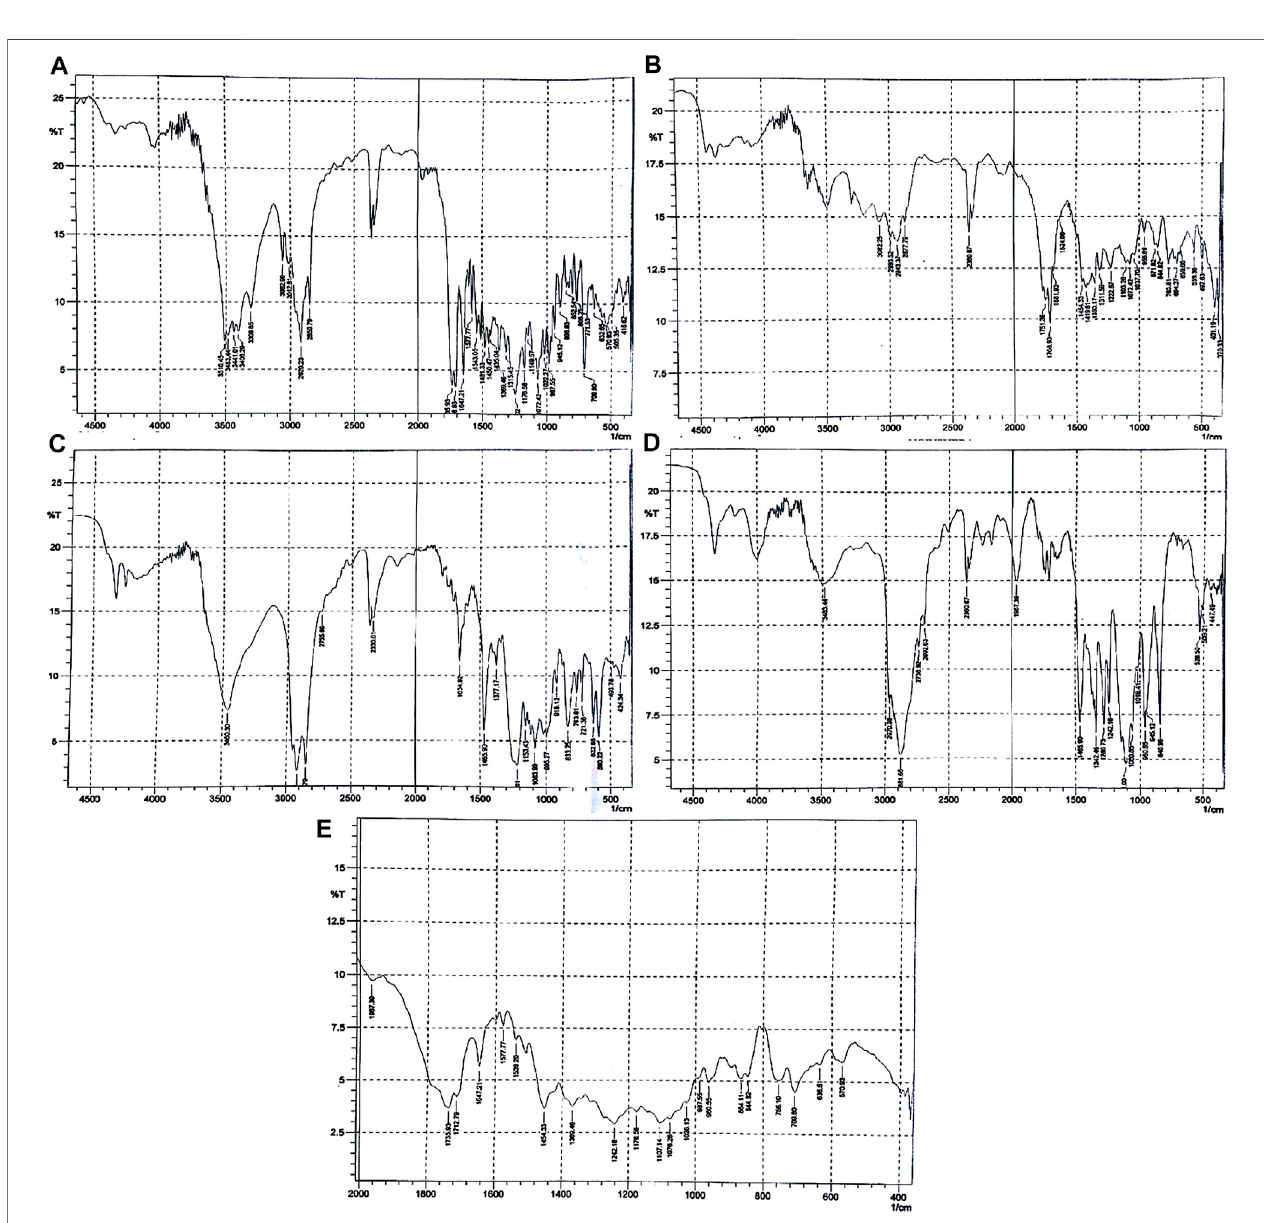
FIGURE 1 | FTIR spectra of (A) paclitaxel, (B) PLGA, (C) SLS, (D) poloxamer 407, and (E) nanoformulation.